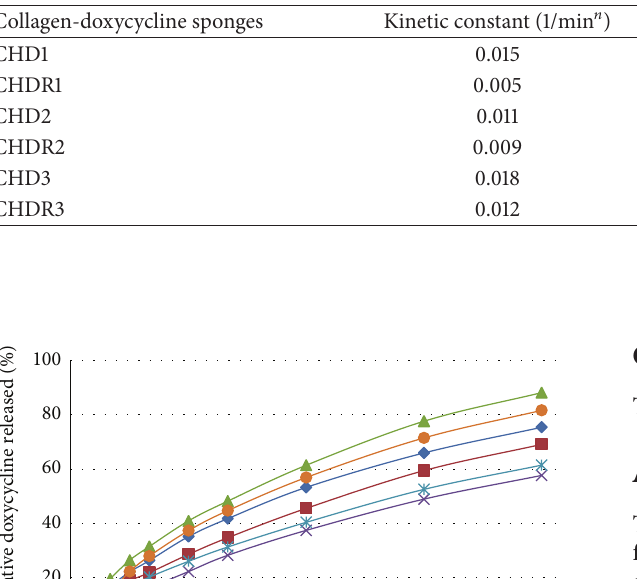
Table 2: The kinetic parameters and the correlation coefficient specific to Peppas model.